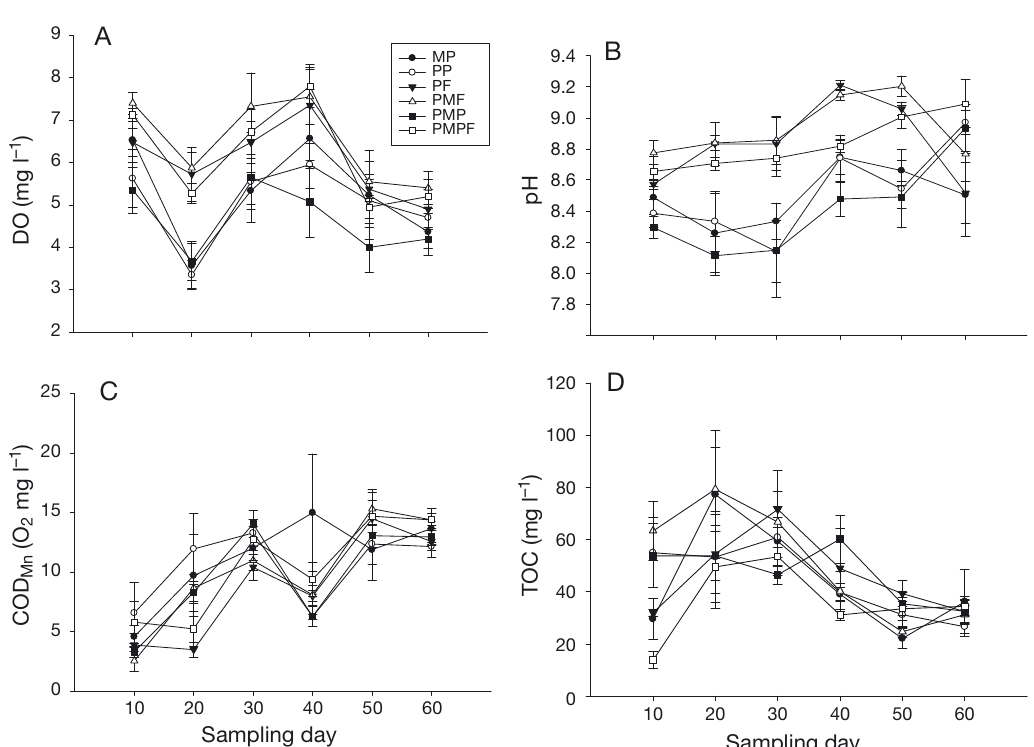
Fig. 1. Temporal dynamics of (A) dissolved oxygen (DO), (B) pH, (C) chemical oxygen demand (COD Mn ) and (D) total organic carbon (TOC) in different treatments during the experiment. Data are presented as means ± SE. Treatment groups are